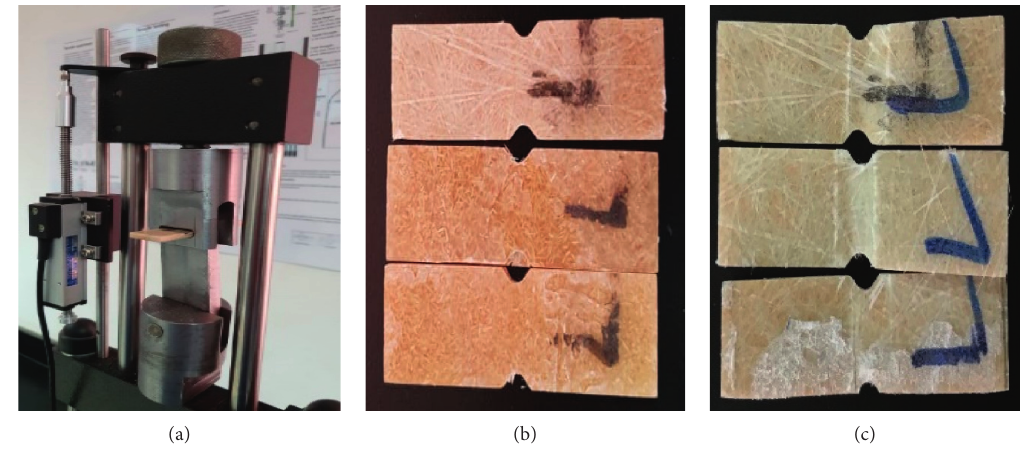
Figure 10: (a–c) Shear specimens before and after